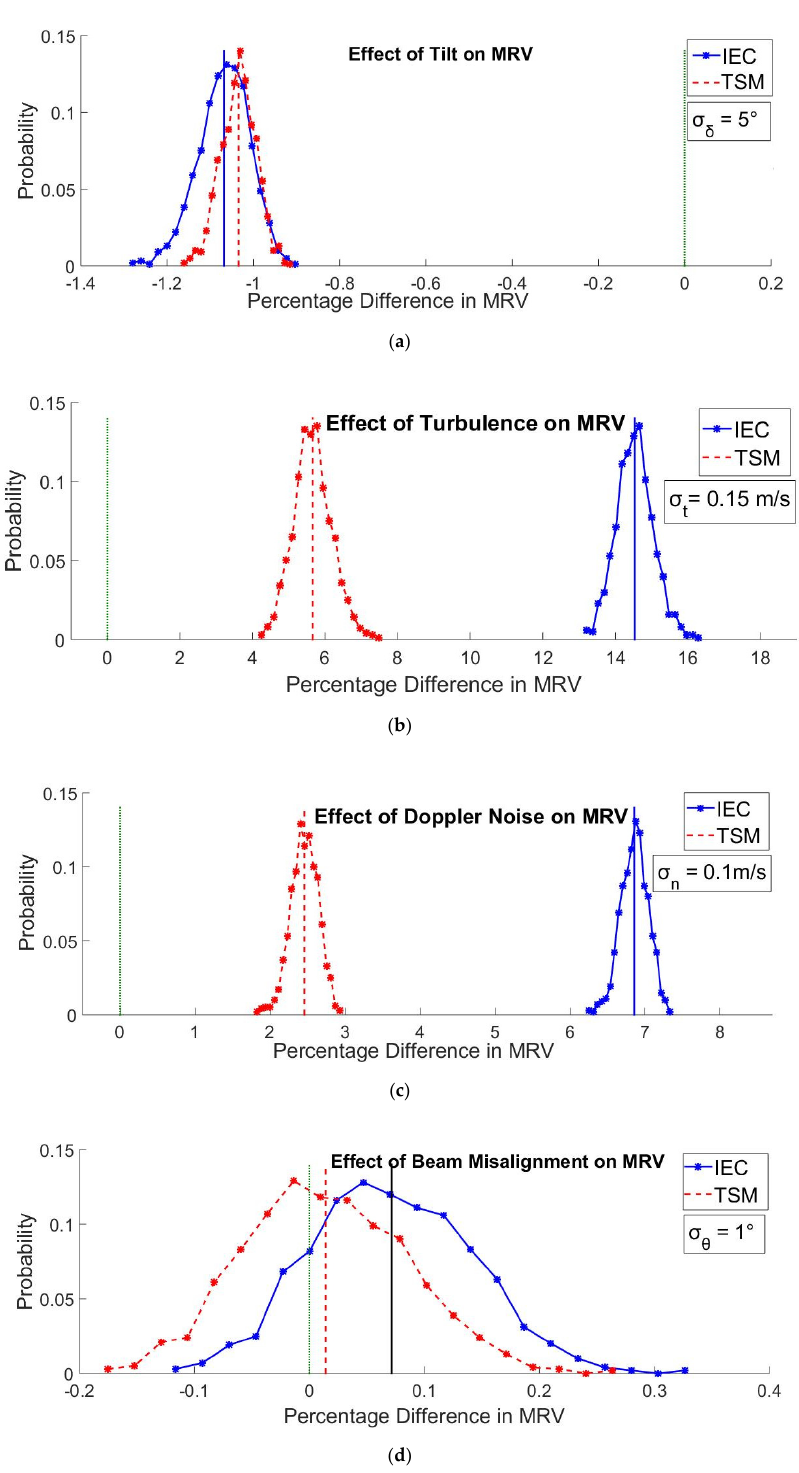
Figure 6. MRV variation due to ( a ) tilt; ( b ) Turbulence; ( c ) Doppler noise; ( d ) Beam misalignment. Here, MRV: Mean Representative Velocity, IEC: International Electrotechnical Commission and TSM: Temporal-Spatial